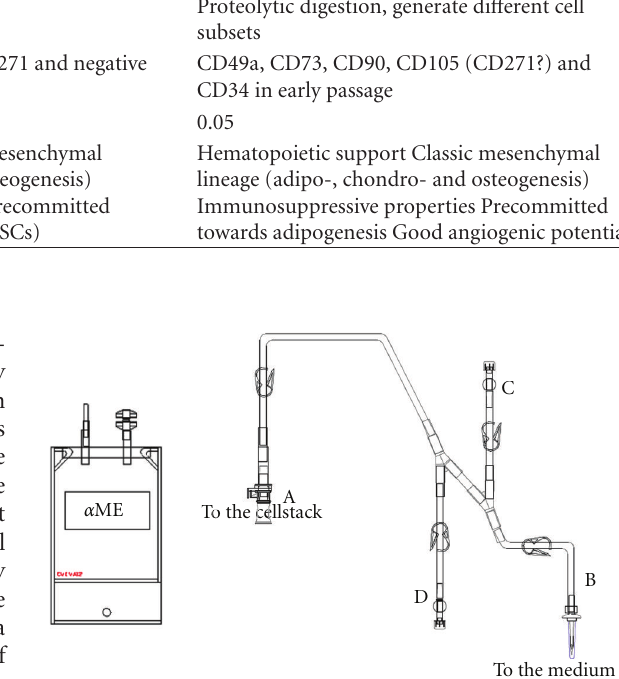
Figure 1: Set of tubing plus medium bag for cell seeding